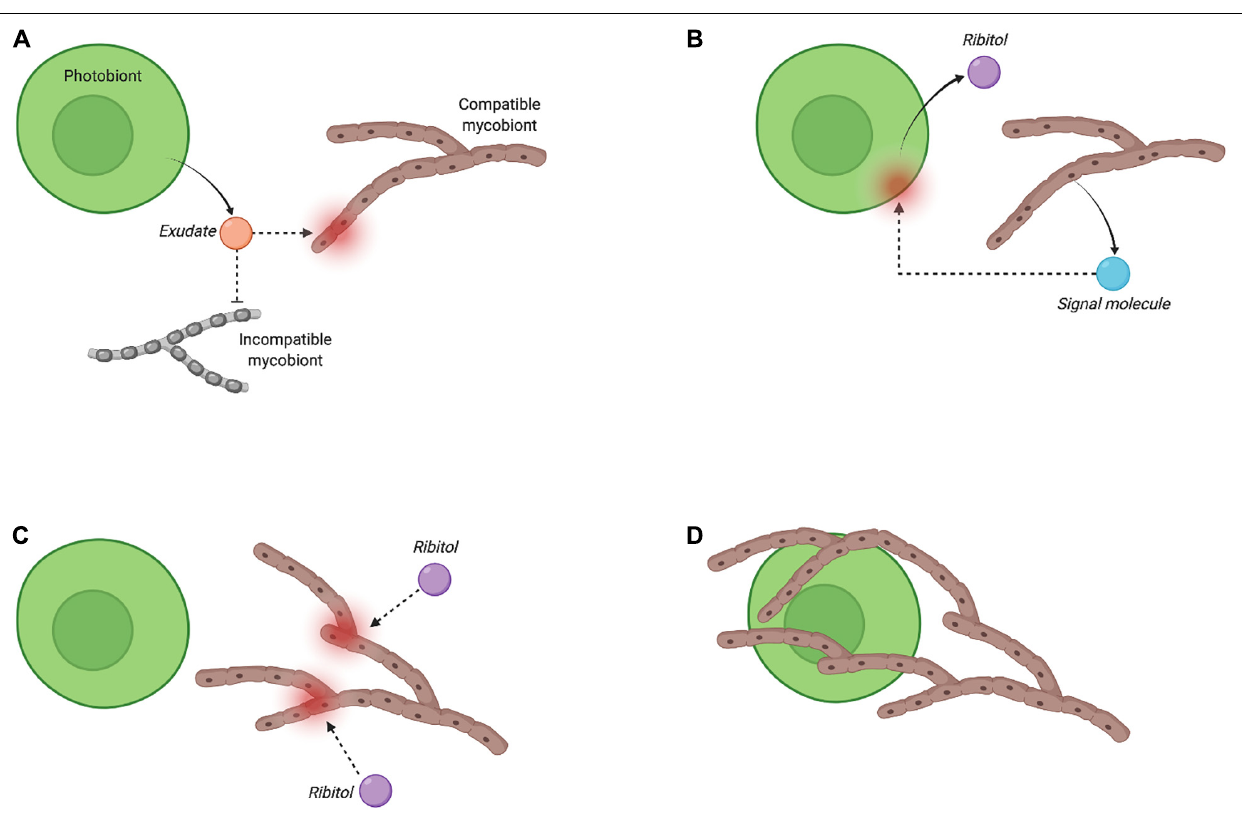
FIGURE 3 | Proposed exudate-based recognition and signalling for Fulgensia bracteata (adapted from Meessen et al., 2013). The bi-directional and multi-step recognition process (i.e., pre-contact stage) is initiated by a compatible photobiont through secretion of an exudate, which is speculated to be species-dependent but has yet to be identified for most lichen species (A) . The exudate induces the production and secretion by the mycobiont of a yet unknown signalling molecule that stimulates ribitol release by the photobiont (B) . Ribitol then triggers fungal growth by relieving hyphal growth arrest (C) , and allowing hyphal branching, and the engulfment of the photobiont cell by the mycobiont (D) . The two last steps may be accompanied by the secretion of a mucilage in some lichens (Meessen et al., 2013; Meessen and Ott, 2013). (Image created with